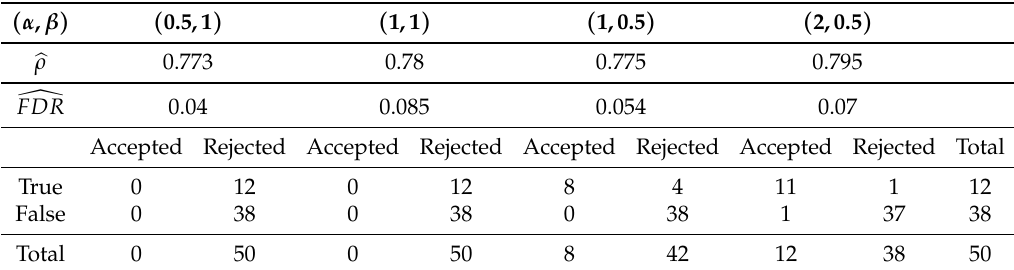
Table 3. Results for the model with Gaussian copulas and for data corresponding to 20% of true null hypotheses to distinct values of the prior distributions of p i